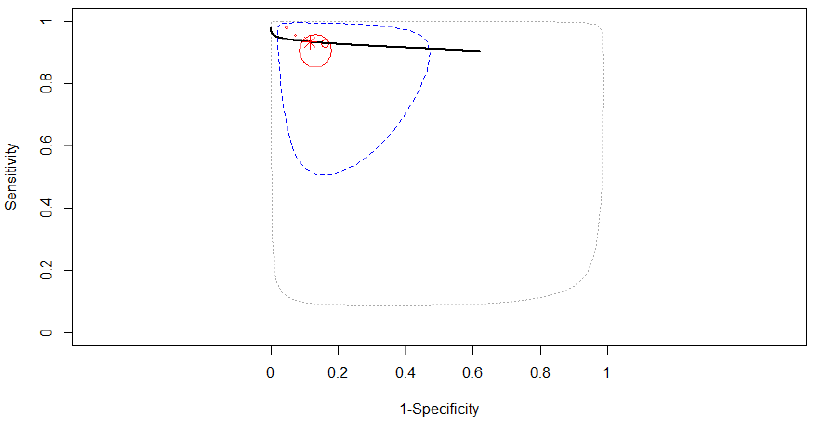
Figure 8. The SROC curve for CNN.